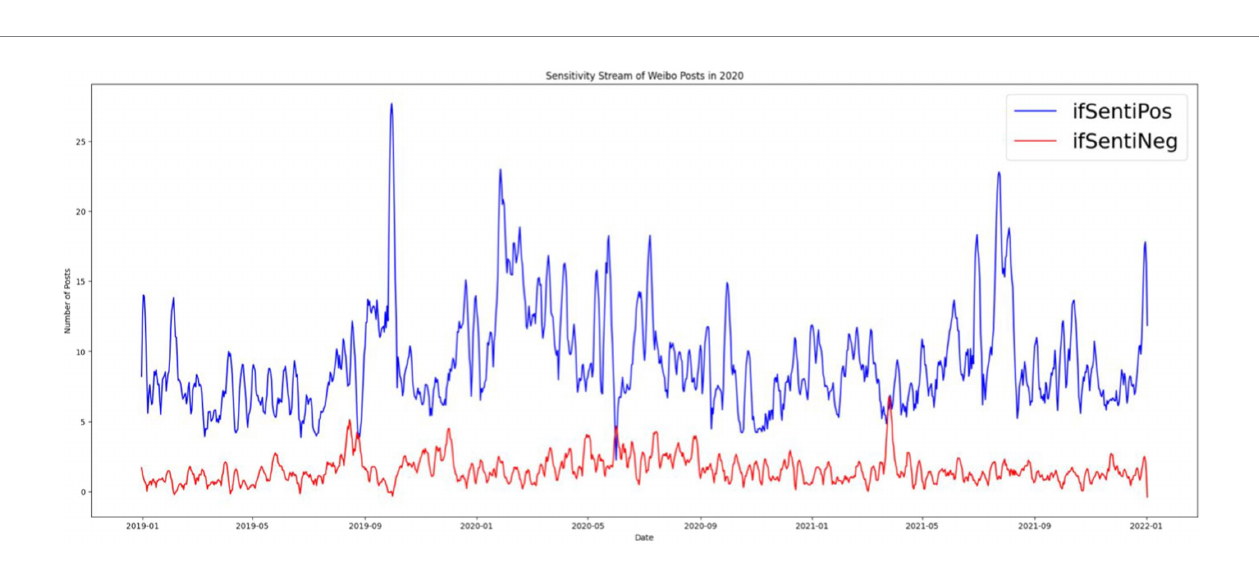
FIGURE 8 Positive and negative sentiment on People’s Daily Weibo account from 2019 to